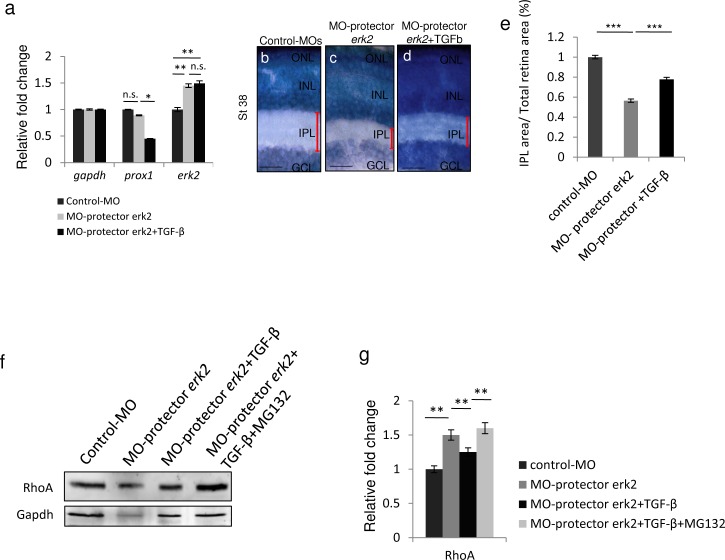
TGF-β signaling regulates erk2 expression by modulating miR-181a/b levels.
(a) qRT-PCR analysis of prox1 and erk2 transcripts in RNA derived from St32 control-MOs, MO-protector-erk2–injected and TGF-β-treated MO-protector-erk2 medaka fish eyes. The TGF-β rescue on the transcript levels of miR-181a/b targets was mediated by the miR-181a/b increase. Indeed this effect on erk2 was completely abolished in the MO-protector-erk2 embryos (a), while other miR-181a/b targets, such as prox1, whose miR-181 binding sites are unaffected by the MO-protector, were still sensitive to TGF-β action. Data are means ± SEM. * P <0.05; ** P <0.01 (two-way ANOVA). (b-d) Retinal frontal sections of St40 Control (b), MO-protector-erk2 (c) and TGF-β-treated MO-protector-erk2 medaka fish embryos (d) processed for Richardson-Romeis staining. Red bars, IPL thickness. Scale bars: 20μm. (e) Quantitative analysis of IPL thickness, indicated as the ratio in the central retina between the IPL area and total retinal area. Data are means ± SEM. *** P <0.0001 (one-way ANOVA). (f-g) Representative Western blotting on protein from St32 eyes (f) and corresponding quantification (g) show that administration of TGF-β to MO-protector-erk2 embryos leads to partial rescue of RhoA protein to levels. When MO-protector-erk2 embryos were treated with both TGF-β and the proteasomal inhibitor MG132, RhoA levels were not rescued anymore. Data are means +SEM. **P <0.05 (one-way ANOVA).